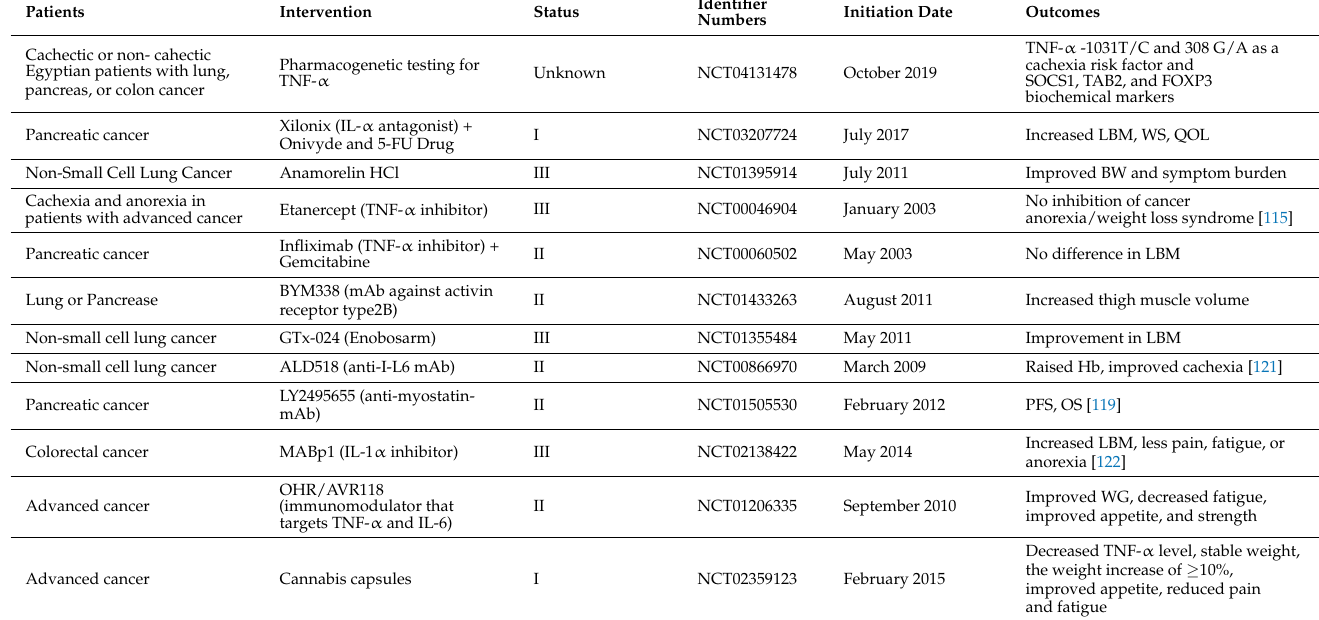
Table 1. Clinical trials overview on cancer or COVID-19-related